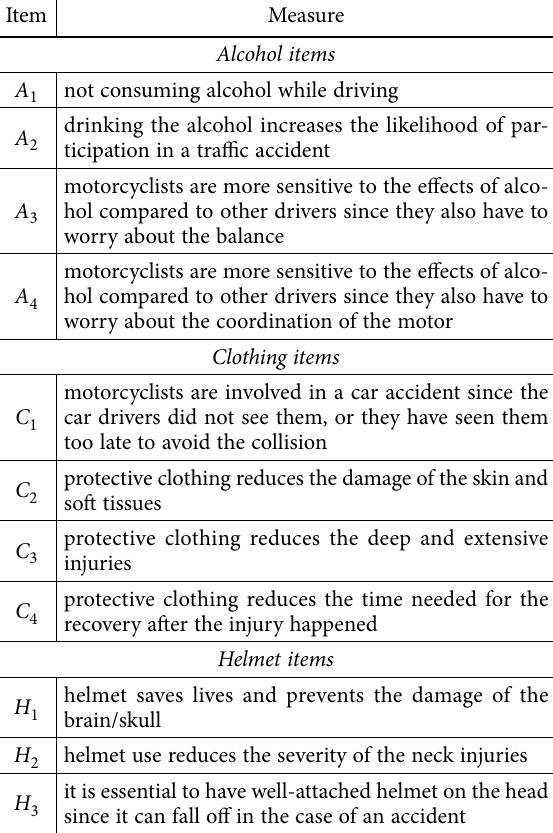
Table 1. Subjective opinion based items of the questionnaire Q1 Table 2. The sample characteristics of measured